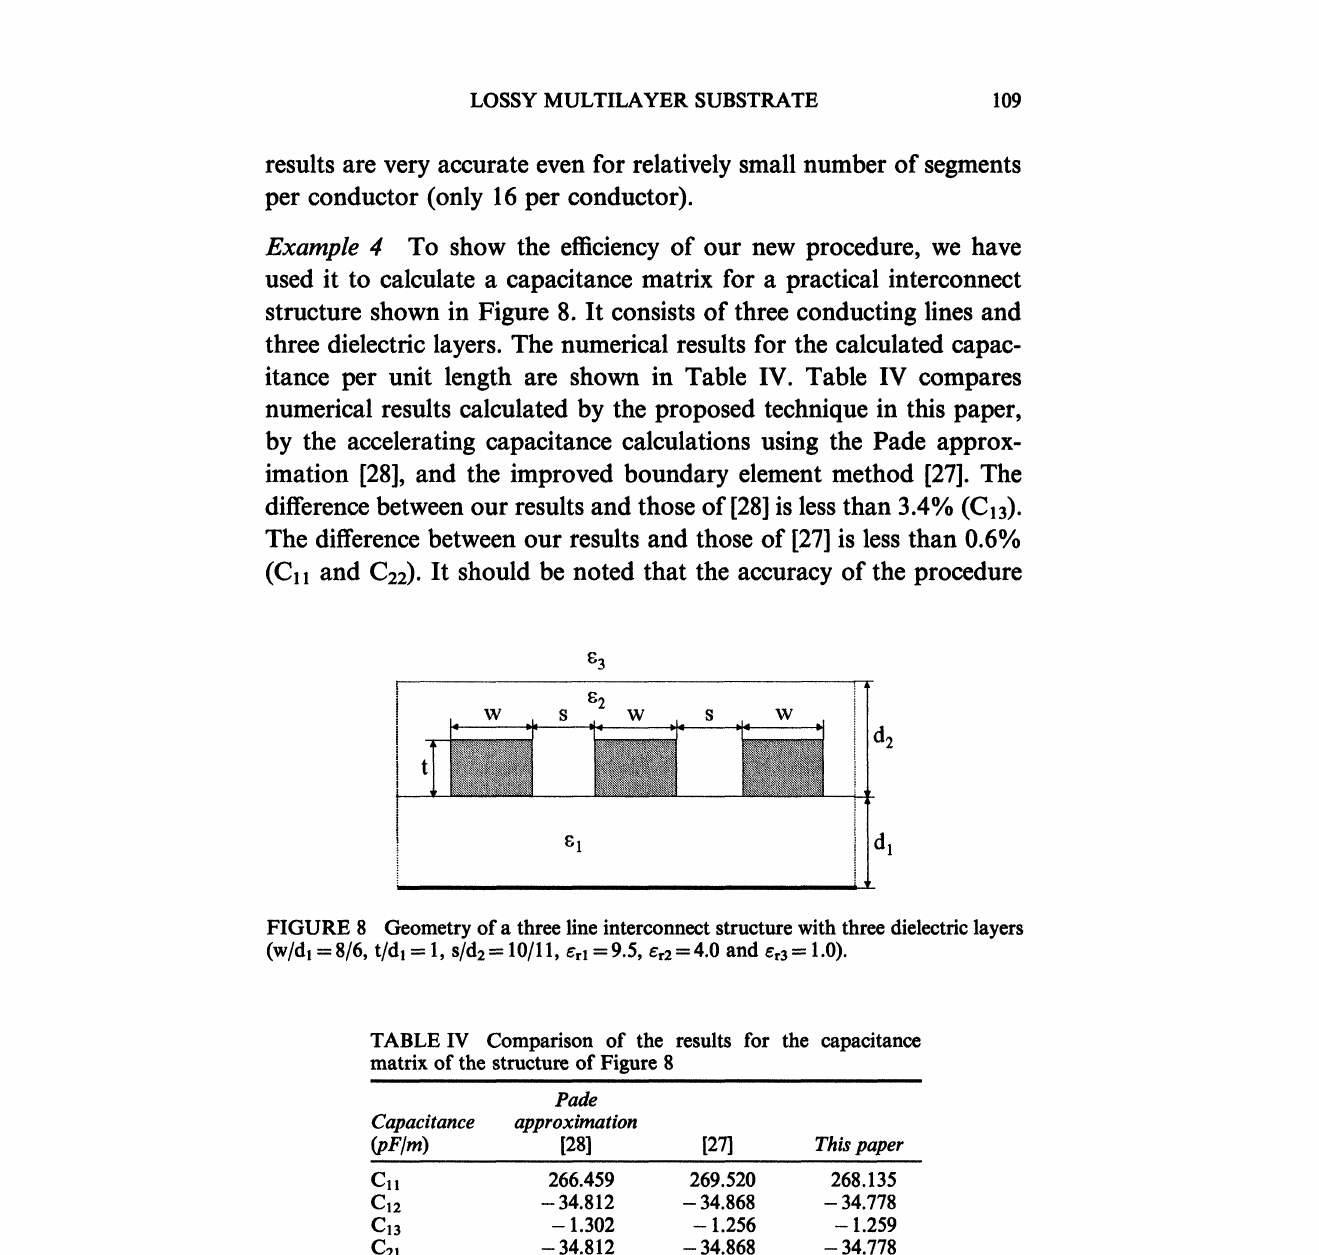
TABLE IV Comparison of the results for the capacitance matrix of the structure of Figure 8 Pade Capacitance approximation